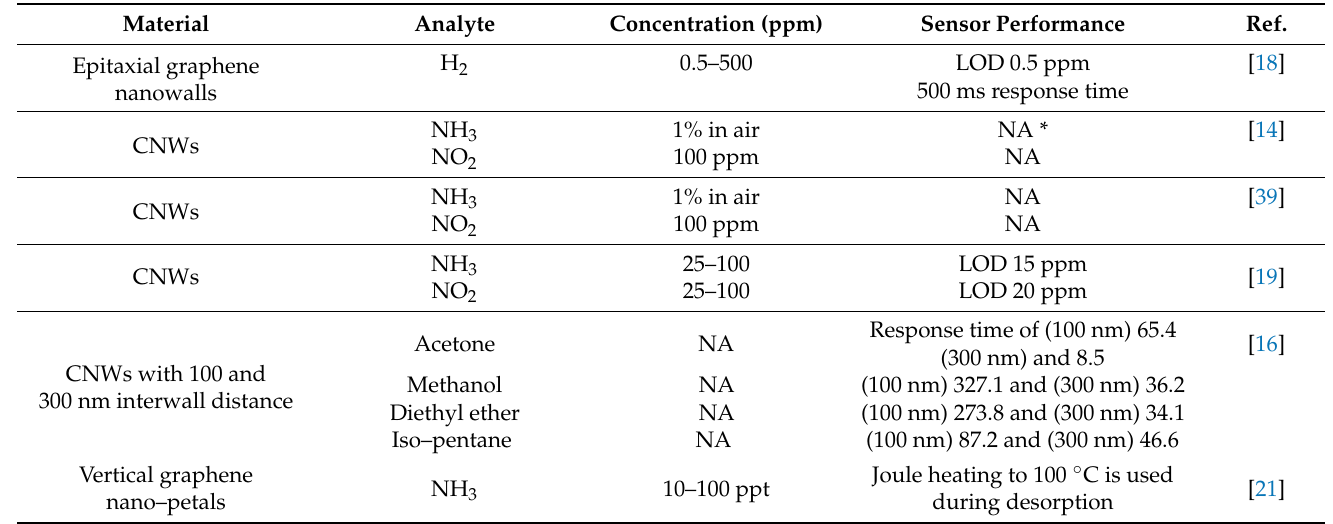
Table 1. Representative examples of NH 3 detection by CNWs and CNW hybrids, together with their performance